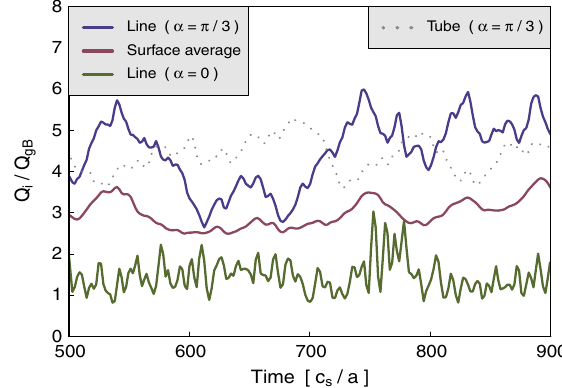
FIG. 2. Ion heat flux (in gyroBohm units) caused by ITG ¼ 2 Þ on the magnetic surface of the QUASAR turbulence ð 1 =L T i stellarator in the small- ρ (cid:3) regime. The time traces correspond to the field line with α ¼ π = 3 (strong turbulence region), the field line with α ¼ 0 (weak turbulence region), and the surface average, demonstrating the stabilization (averaging) effect. Also shown is the time trace from a separate flux tube simulation surrounding the field line with α ¼ π = 3 , suggesting the local nature of stellarator turbulence in small- ρ (cid:3)